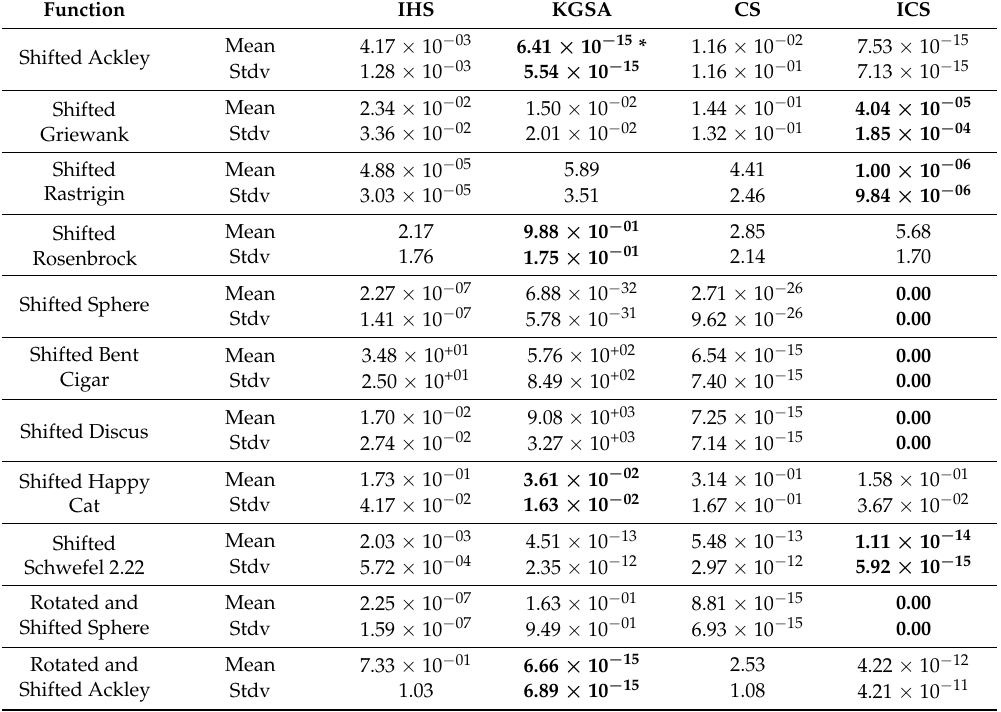
Table 3. Errors of test results of the